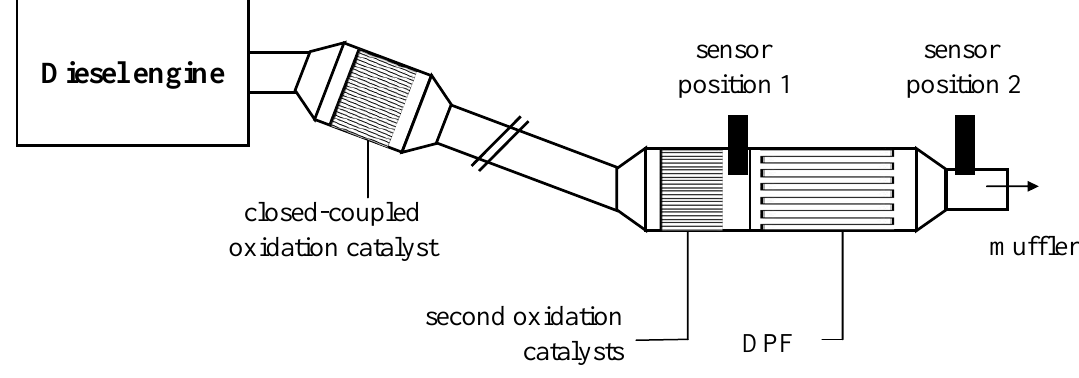
Figure 2. Setup of engine and sensor positions. The second test with a sensor at “sensor position 2” was conducted without the second oxidation catalyst.